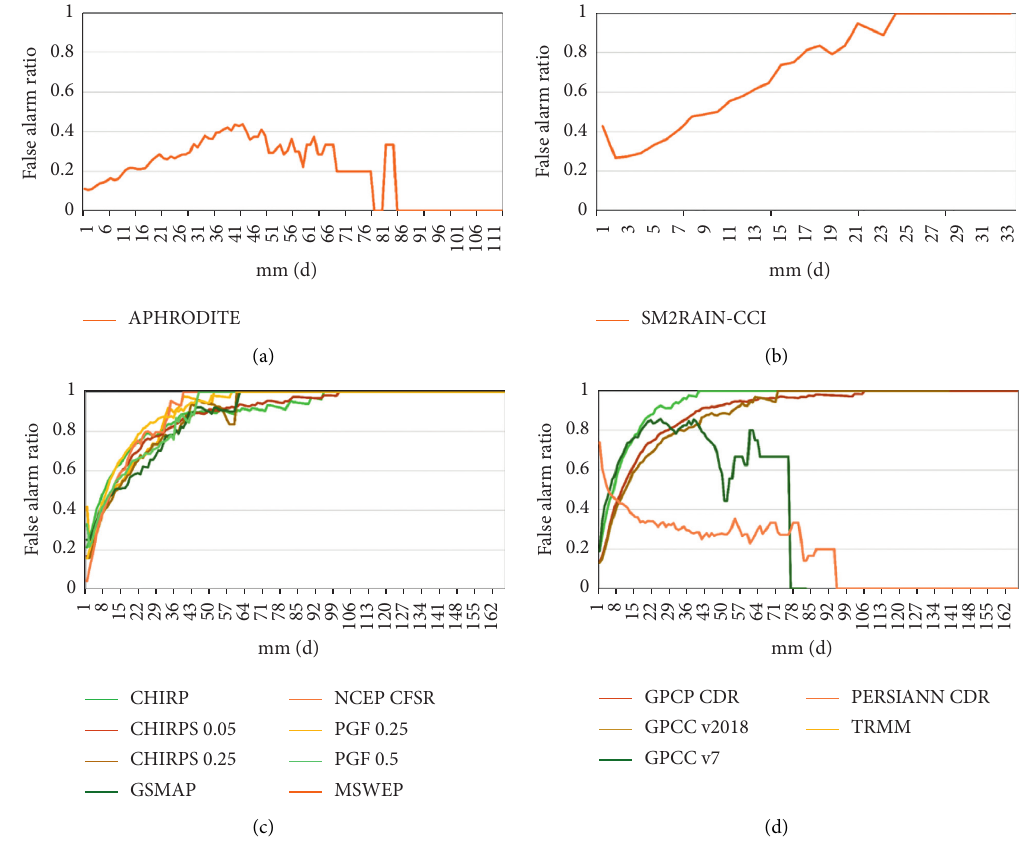
Figure 6: Line graphs indicating FAR were plotted for (a) gauge-based product, (b) satellite-only product, (c) reanalysis products, and (d) gauge-adjusted products against IMD gridded